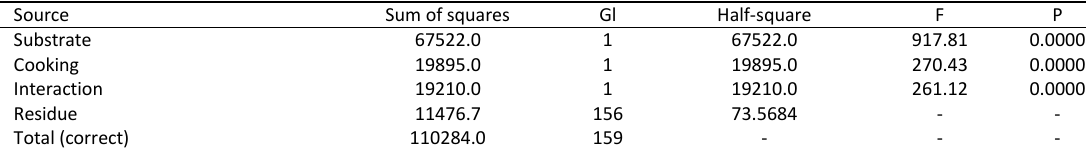
Fig. 3: Mortality of Hermetia illucens larvae for each treatment over time. Larval growth system (T1: raw beef blood, T2: raw beef viscera, T3: cooked beef blood, T4: cooked beef viscera, T5: control (balanced feed), T6: raw chicken viscera, and T7: cooked chicken viscera) Table 4: ANOVA Hermetia illucens larvae mortality at day 5